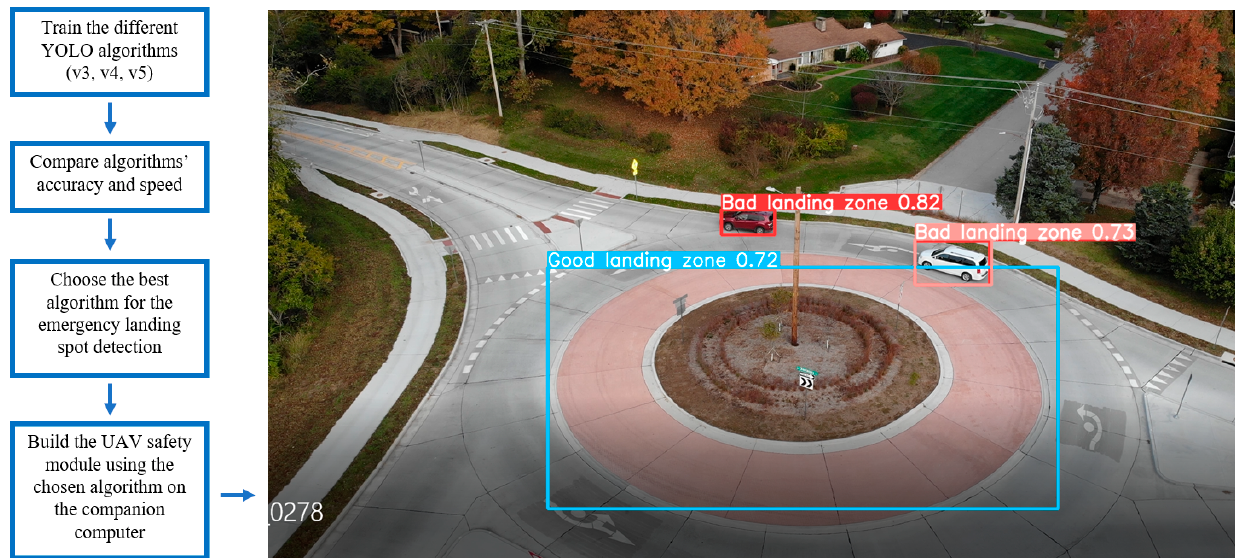
Figure 1. Flowchart of the steps involved in this work ( left ) and the output of the chosen algorithm (YOLOv5l) working on a video stream of a UAV flying near Southern Illinois University campus ( right ) All UAV flights for this project were operated in accordance with FAA regulations.